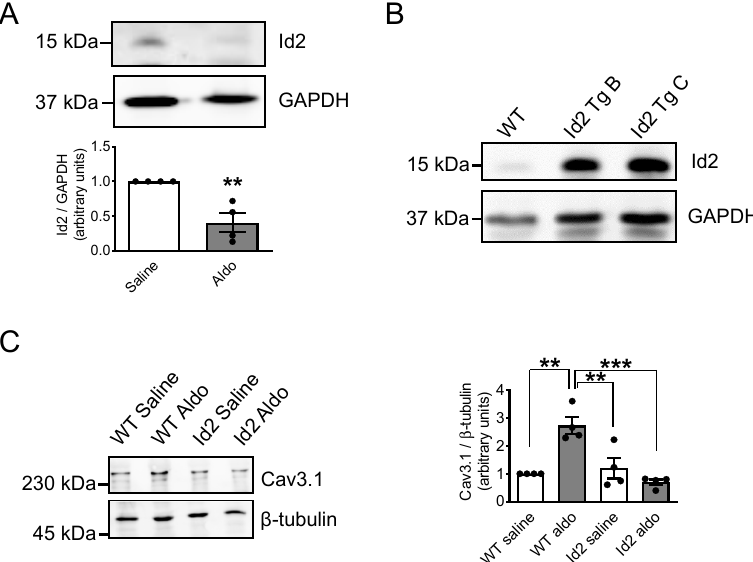
Figure 6. Id2 expressing transgenic mice prevents the aldosterone-stimulated expression of CaV3.1 voltage-gated calcium channels in vivo. WT or cardiomyocyte-specific Id2 expressing transgenic B6D2F1/Slc mice were stimulated with Aldosterone (60 mg/Kg/day) or Saline solution for 1 week by implanting subcutaneously osmotic pumps. ( A ) Representative pictures of western blot experiments showing the Id2 protein (upper) and GAPDH protein (lower) expression levels from the heart of WT mice treated with saline solution or aldosterone. The bar graph is the mean of Id2 expression ( n = 4). ( B ) Pictures of western blotting experiments showing the Id2 protein (upper) and GAPDH protein (lower) expression levels in the heart of B6D2F1/Slc WT and two cardiomyocyte-specific Id2 expressing transgenic (Tg) mice. ( C ) Pictures of western blotting experiments showing CaV3.1 (upper) and tubulin (lower) proteins expression levels in WT or Id2 transgenic mice treated with saline solution or aldosterone. Graph is are the mean expression of CaV3.1 and tubulin expression ( n = 4). The data were evaluated by one-way analysis of variance (ANOVA) followed by Tukey–Kramer’s post hoc test or by unpaired two-tailed Student’s t -test. Bars and error bars indicate the mean ± s.e.m., ** p < 0.01, *** p < 0.001.